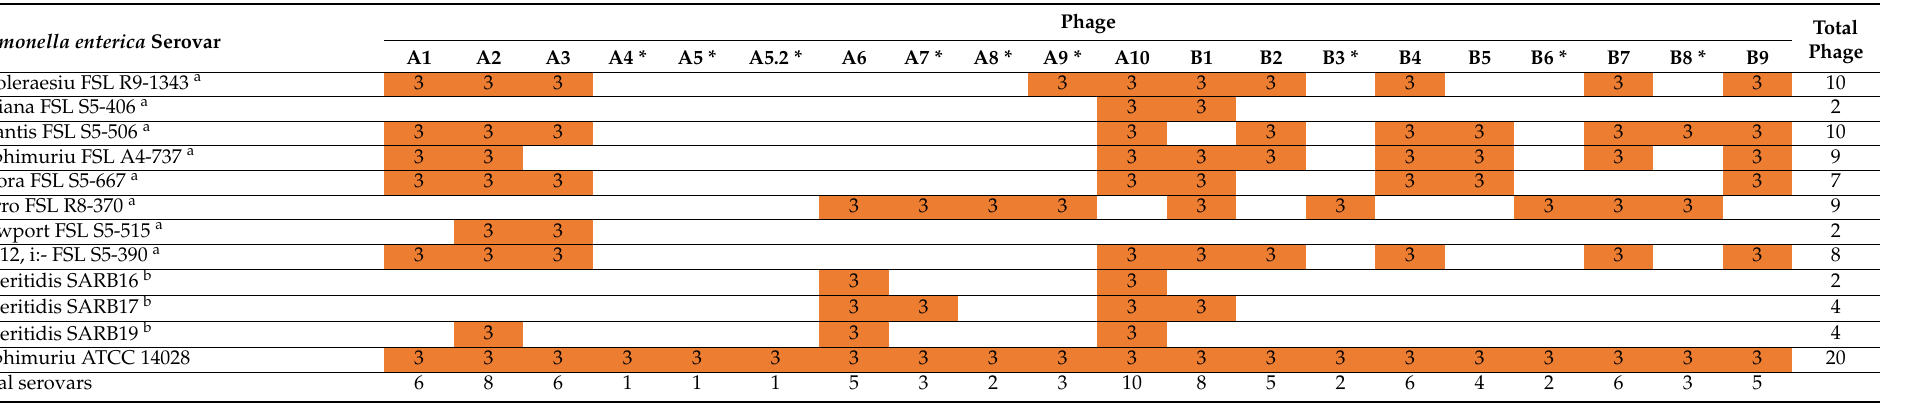
Table 1. Host range of